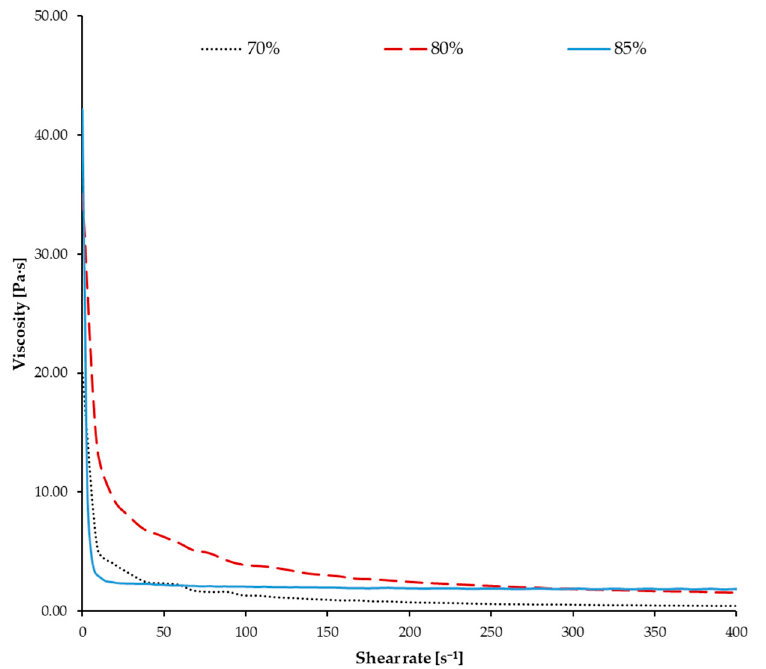
Figure 7. Viscosity vs. shear rate of slurries with different solid loadings.